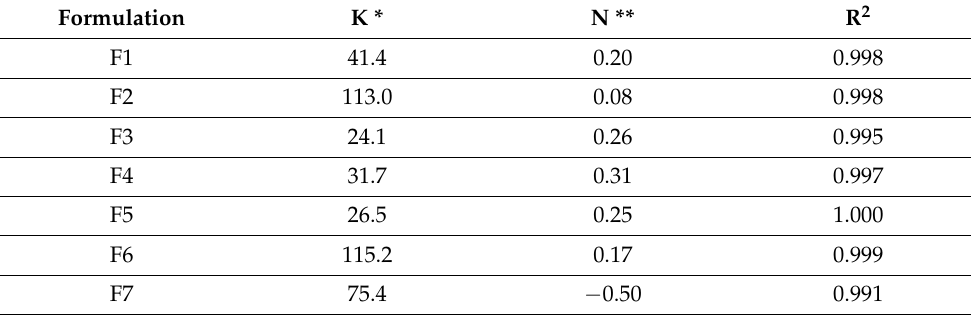
Table 3. Mathematical analysis of the power-law model.